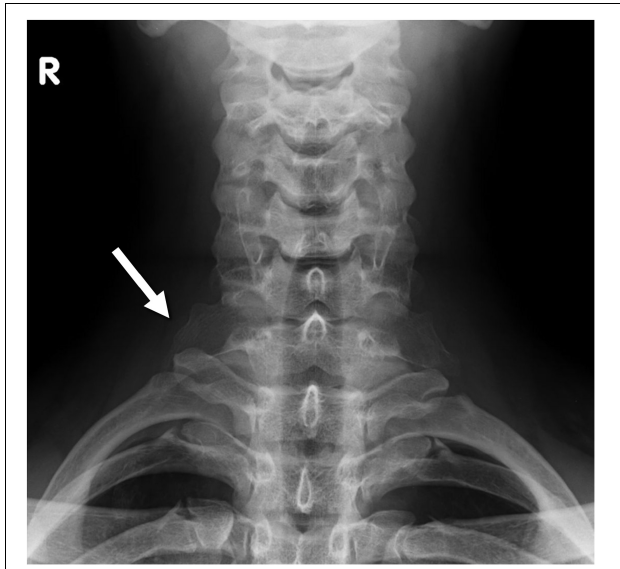
FIGURE 1 | Radiograph of the cervical spine shows a stump rib on both sides (white arrow).